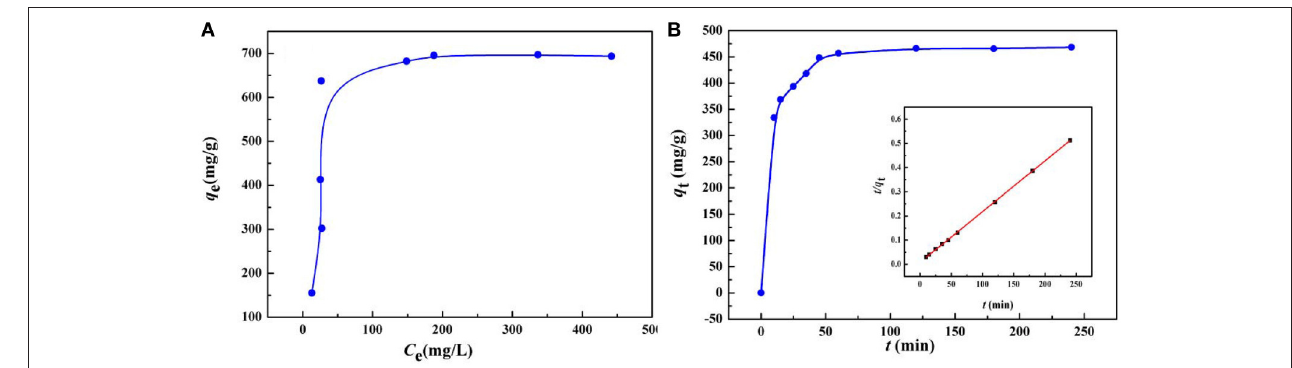
FIGURE 8 | (A) Adsorption isotherm and (B) adsorption kinetics of Hg(II) onto KF@VIM/EGDMA adsorbents. Adsorption experiments: (A) sample dose: 20mg/25mL; pH: 5.5; t : 120min; temperature: 30 ◦ C. (B) C 0 : 400mg/L; sample dose: 20 mg/25mL; pH: 5.5; temperature: 30 ◦ C.